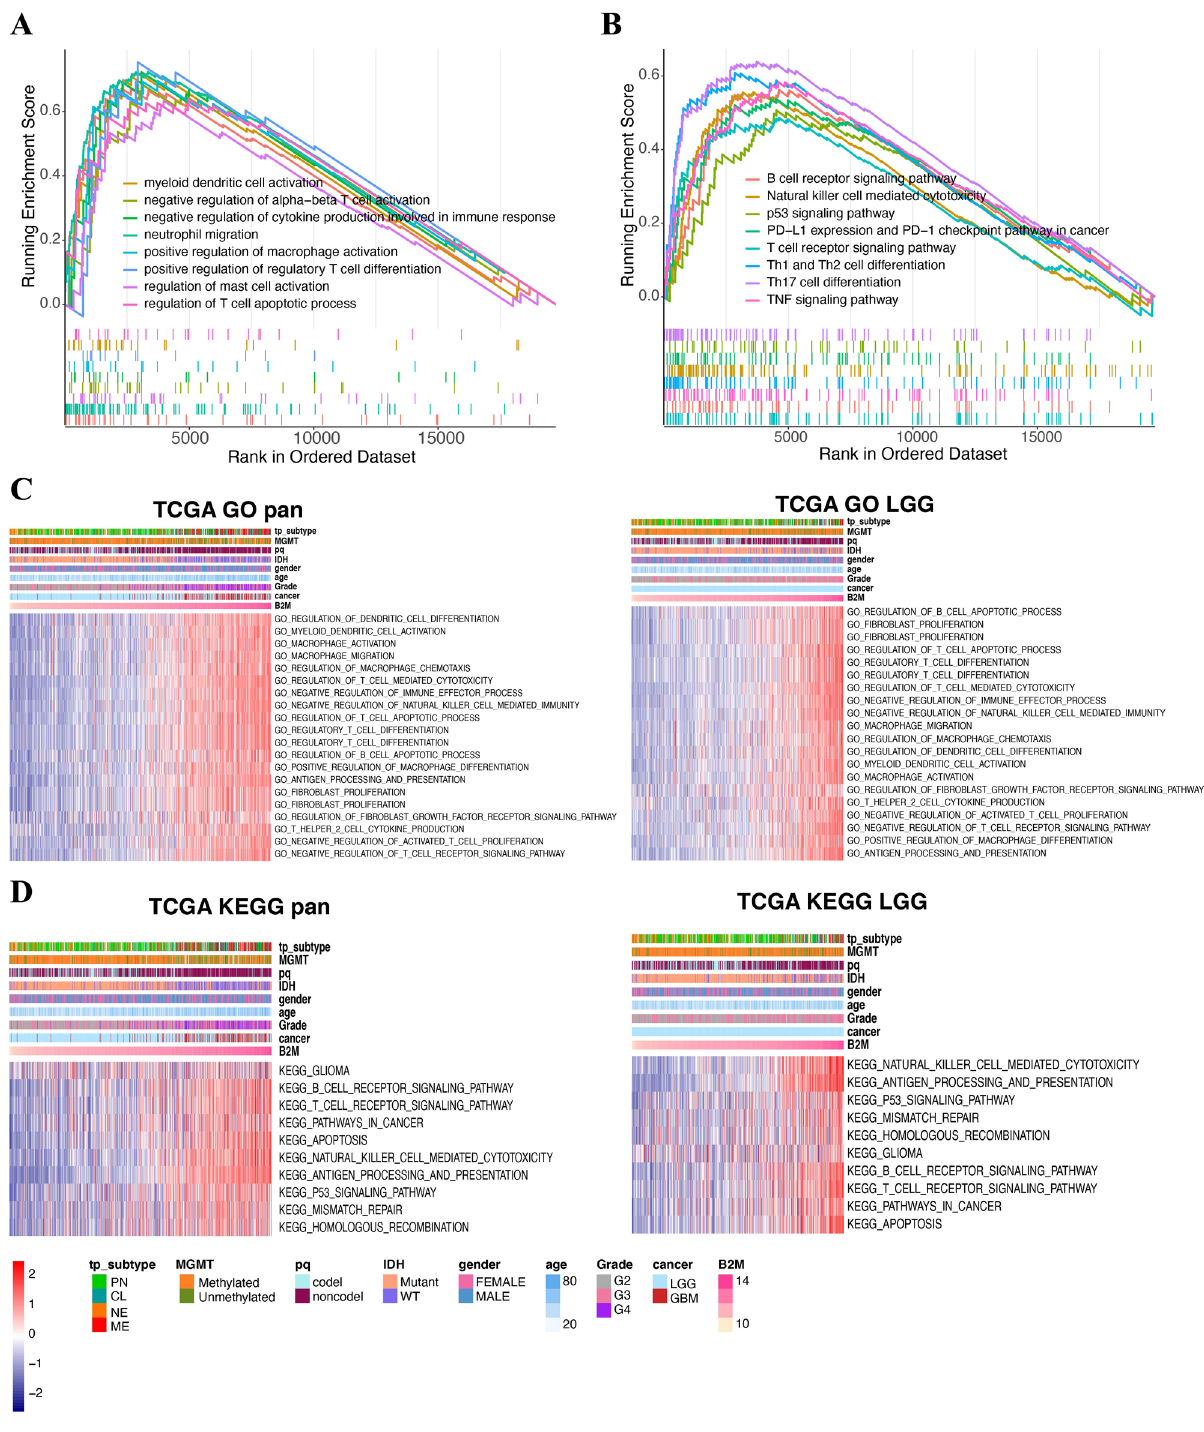
Figure 4. B2M-related immune functions in gliomas. ( A , B ) GSEA plots for enrichment of immunogenic and oncogenic signaling pathways from the GO ( A ) and KEGG ( B ) database 25–27 , respectively. ( C , D ) The relationship between B2M and biological processes in pan-gliomas and LGGs from TCGA dataset. Results are based on the GO ( C ) and KEGG ( D ) databases 25–27 , respectively. Expression values of B2M are z-transformed and are colored red for high expression and blue for low expression, as indicated in the scale